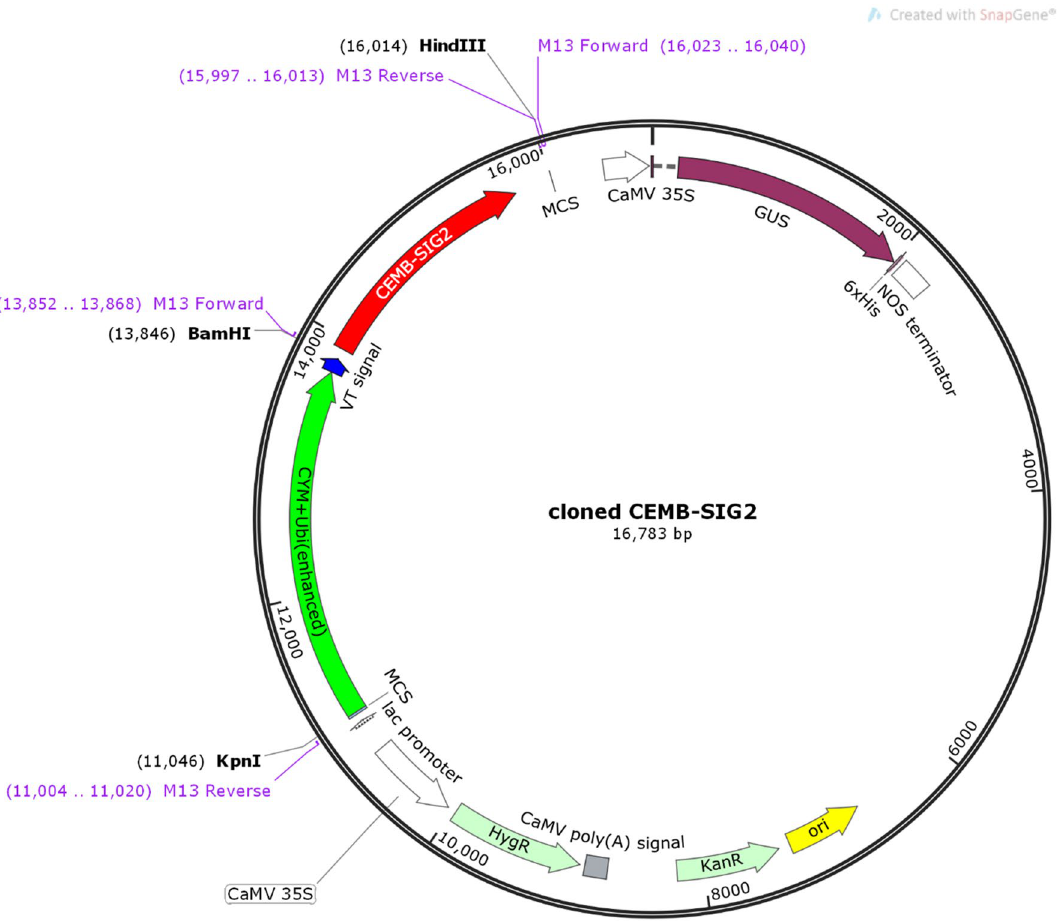
Figure 1. Circular gene map (16,783 bp) exhibiting inclusion of cloned ThSyGII(CEMB-SIG2) in red arrow driven CmYMV and pUbi promoters (green arrow) while VTS was shown in blue